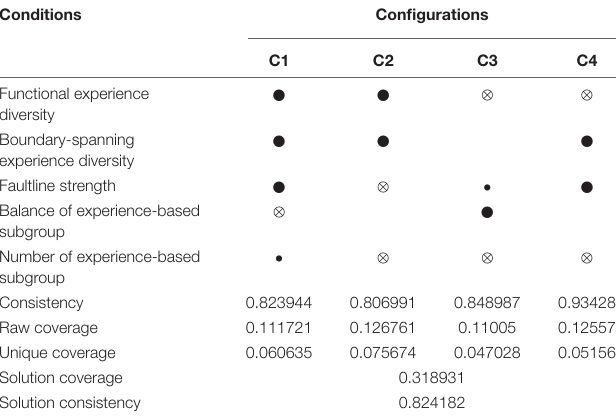
TABLE 3 | Configuration for achieving high innovation performance.